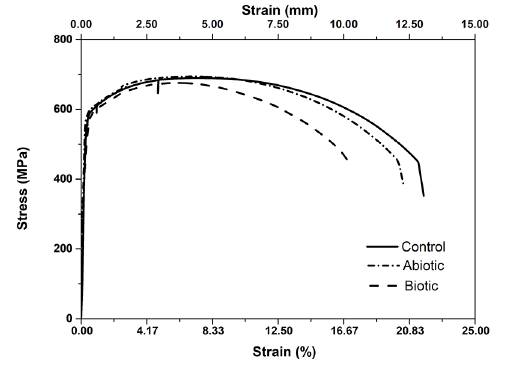
Figure 5. Stress-strain curve of API 5L X80 steel coupons in periods without exposure (control) and after 360 days of exposure to abiotic and biotic systems.